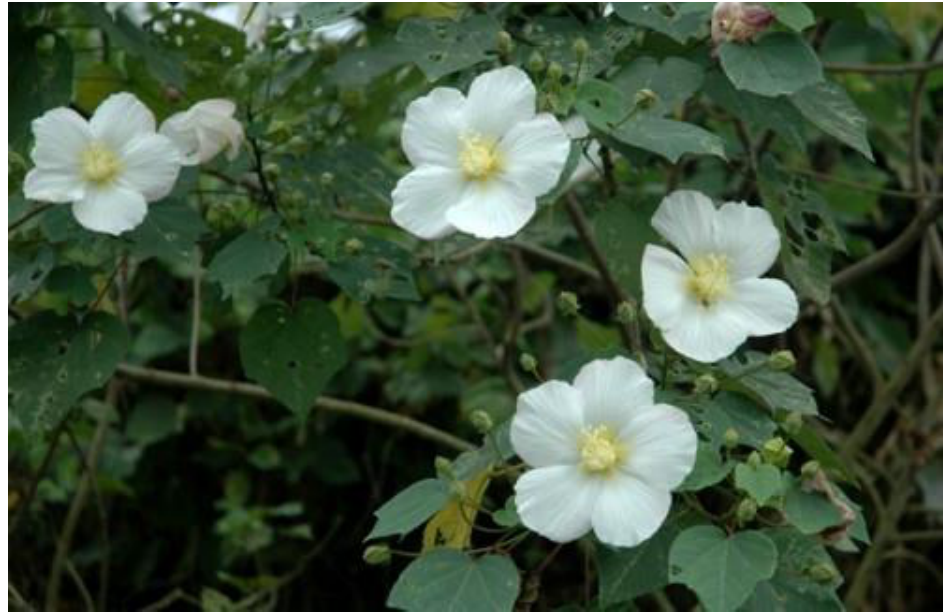
Figure 1. A picture of Hibiscus taiwanensis S. Y. Hu. At present, the extraction methods by water and organic solvents (such as methanol or acetone) are mainly employed to obtain the extracts of Hibiscus taiwanensis S. Y. Hu [3,6,10,11]. For example, using methanol as a solvent, Wu’s team extracted and isolated three new phenylpropionates from the stem of Hibiscus taiwanensis S. Y. Hu, and tested their cytotoxic activity against human lung and breast cancer cells [6]. Using methanol as solvent, Lee et al. isolated 56 chemical components, including ferulic acid from Hibiscus taiwanensis S. Y. Hu, among which five compounds, namely hibicuslide A, hibicuslide B, hibicuslide C, hibicu- taiwanin, and hibicusin were newly discovered [3]. Liu et al. employed water as a solvent to extract Hibiscus taiwanensis S. Y. Hu found seven main phenolic compounds, namely ferulic acid, p -coumaric acid, gallic acid, syringic acid, chlorogenic acid, vanillic acid, and caffeic acid, and detected their anti-inflammatory activity to lps-induced RAW264.7 cells and carr-induced mouse foot edema [10]. Wang et al. used an acetone aqueous solution to immerse and extract Hibiscus taiwanensis S. Y. Hu, and described the hypoglycemic effect of the extracts, including syringaldehyde, on the plasma of streptozotocin-induced diabetic rats [11]. The use of a large amount of organic solvents has the disadvantages of negative environmental impact as well as complicated and tedious processes. In addition, a large number of active ingredients may lose their activity in the processes of repeated high-temperature concentration and recovery of organic solvents due to the photothermal instability of the functional components of Hibiscus taiwanensis S. Y. Hu, which may cause enormous losses. Therefore, there is an urgent need for a more advanced new technol- ogy with less environmental pollution and less damage to functional components. The supercritical carbon dioxide extraction [12–15] is a green, efficient, and highly